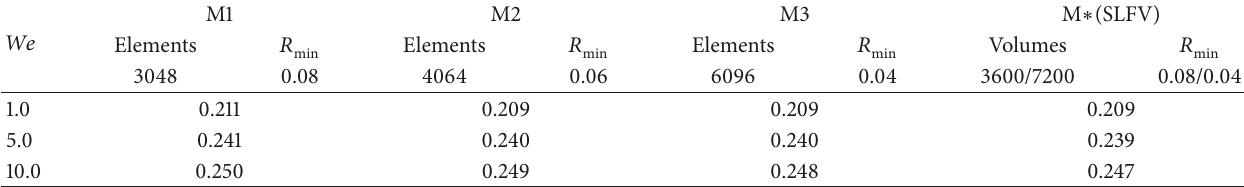
Table 4: Mesh convergence: salient-corner vortex cell size ( Re = 0.0)